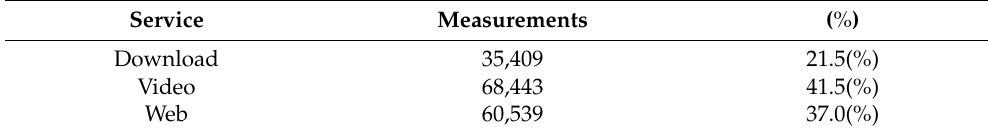
Table 2. Statistics and rate of selected